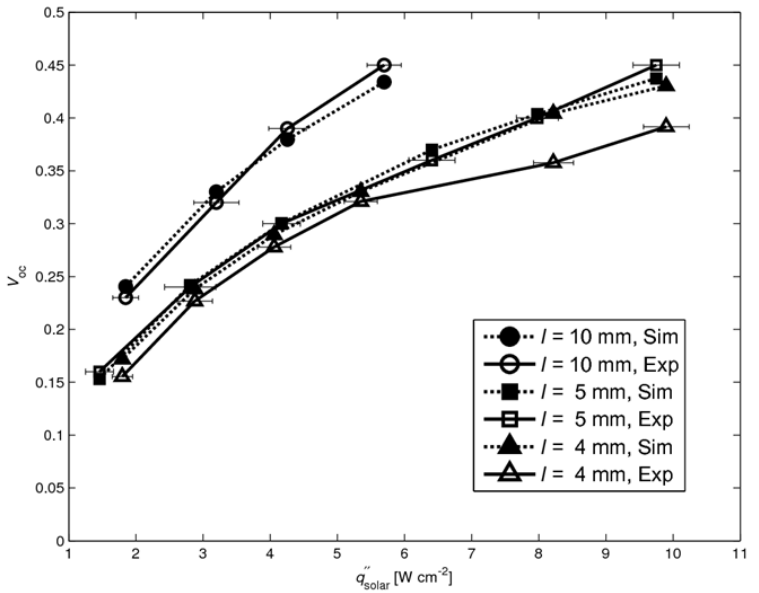
l = 4, 5, 10 mm. Error bars indicating uncertainty of incident solar radiative flux.